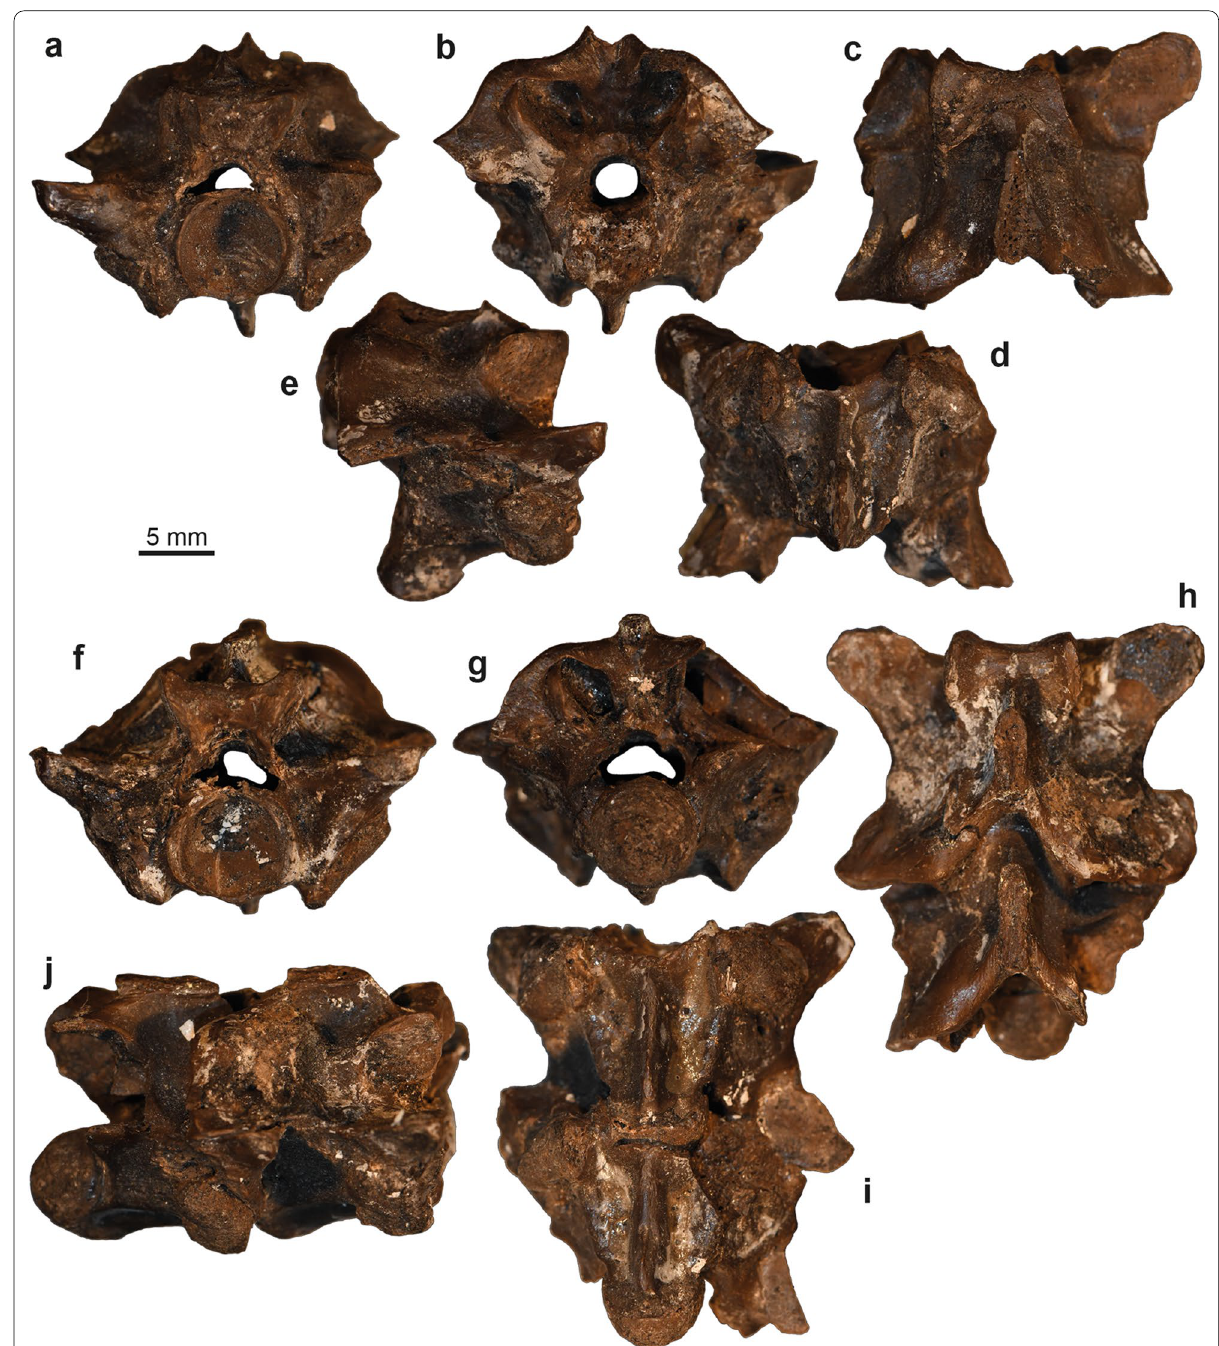
Fig. 30 Palaeopython ceciliensis from unknown quarry, Geiseltal: a – e anterior trunk vertebra (GMH Y-38d) in anterior ( a ), posterior ( b ), dorsal ( c ), ventral ( d ), and right lateral ( e ) views; f – j two articulated mid-trunk vertebrae (GMH Y-38f) in anterior ( f ), posterior ( g ), dorsal ( h ), ventral ( i ), and right lateral ( j )